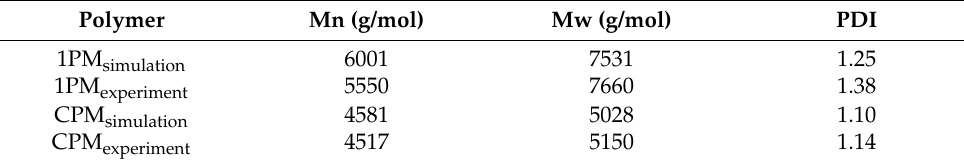
Figure 8. ( a ) Simulation and experimental molecular weight distribution of copolymer 1-pentene– maleic anhydride (1PM); ( b ) simulation and experimental molecular weight distribution of copolymer cyclopentene–maleic anhydride (CPM); the results were normalized to 1 for comparison. Table 3. Molecular weight and molecular weight distribution of simulation and